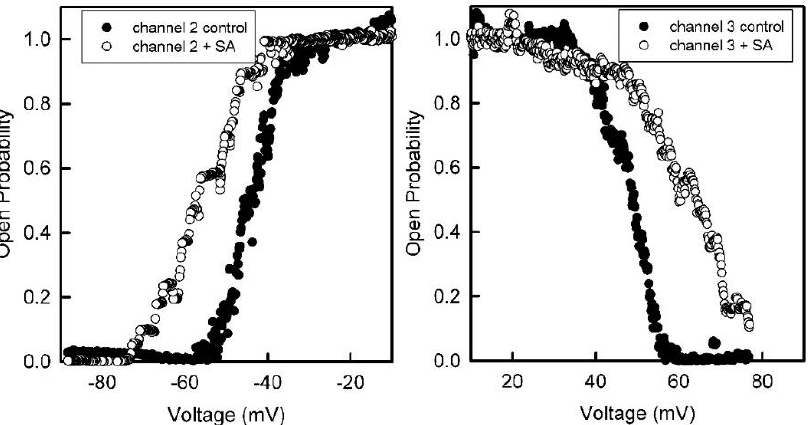
Figure 4. The voltage dependence of the probability of subunits 2 and 3 being in the open state before and after treatment with succinic anhydride (+SA) added to both sides of the membrane.